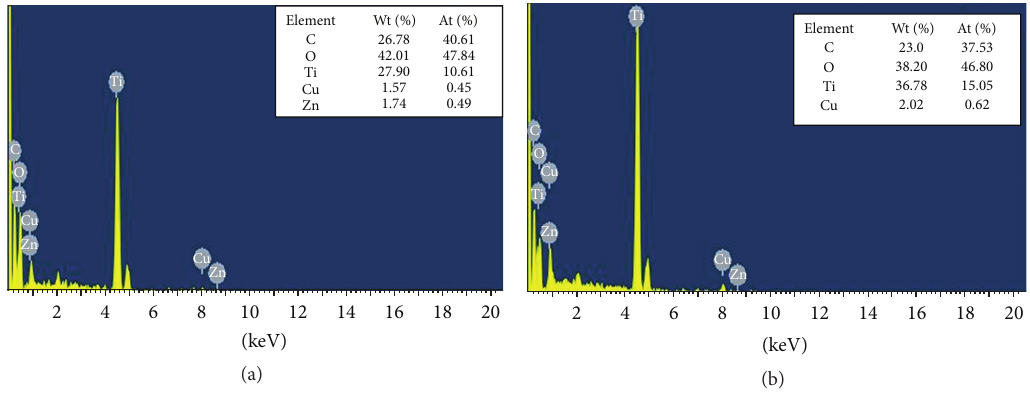
Figure 10: EDX analysis of pure titanium after